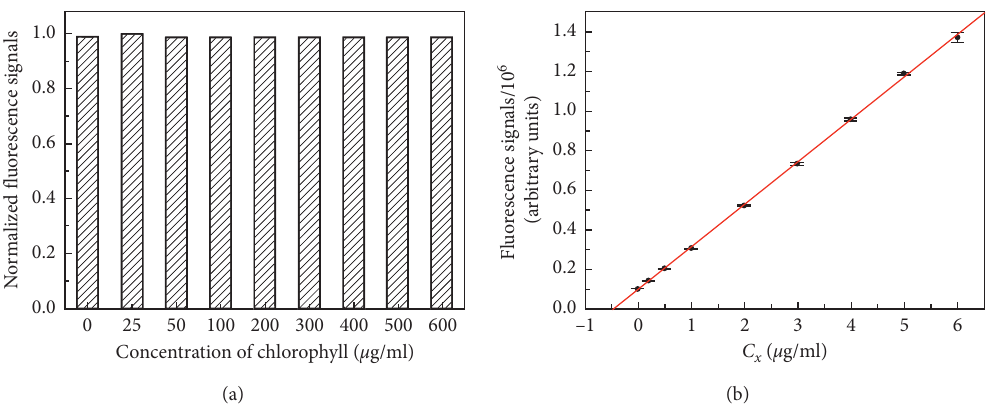
Figure 5: Fluorescence experiment of catechin in chlorophyll environment. (a) Comparison of emission peaks of chlorophyll aqueous solution at different concentrations. (b) Chlorophyll fluorescence area fitting, with increasing catechin concentration. The Pearson co- efficient and the coefficient of determination of the fitted straight line in the figure are all greater than 0.99. All experimental data are averaged after three experiments.